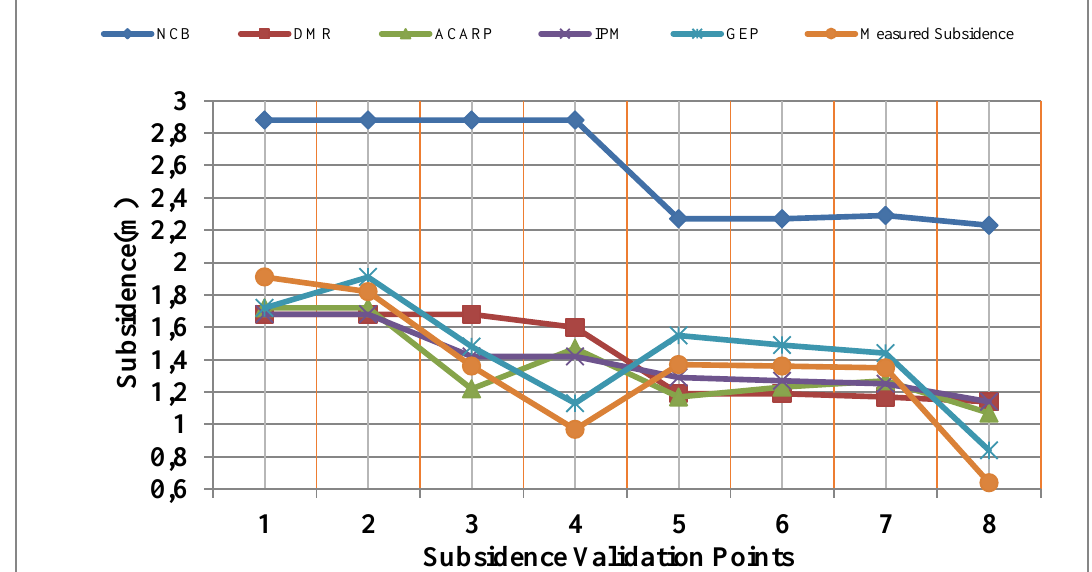
Figure 11: Prediction methods results vs. measured data. Table 9: Statistics results of the proposed GEP model vs. other